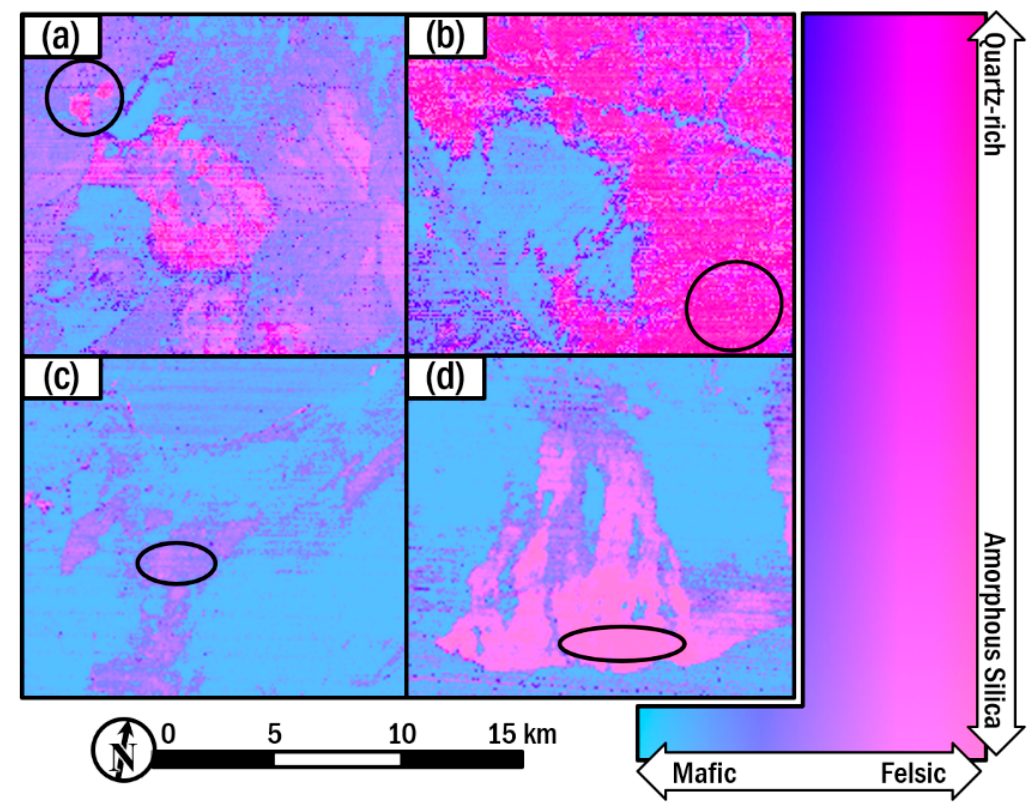
Figure 4. Images generated by integrating the T-depth and T-angle, which can distinguish between quartz (( a ), ( b )), and amorphous silica (( c ), ( d )): (a) quartzite in Cuprite, Nevada, USA; (b) Navajo Sandstone in Utah, USA; (c) Obsidian in the hills in the southern part of Mono Lake, California, USA; (d) thin silica coating on pahoehoe lava in Kilauea, Hawaii, USA. The ellipses indicate representative areas where these target rocks are distributed. Coordinates of the ellipse centers; (a) 37°37’17.14’’ N / 117°17’26.87’’ W, (b) 37°42’05.32’’ N / 111°22’35.22’’ W, (c) 37°53’39.43’’ N, 119°00’29.60’’ W, (d) 19°16’34.93’’ N, 155°09’21.74’’ W.